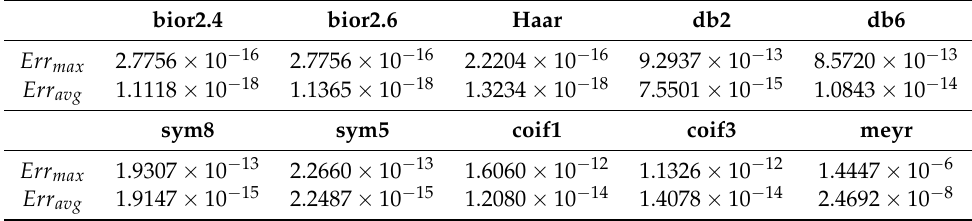
Figure 3. ( a ) Echos filtered by moving averaging methods; ( b ) echos filtered by wavelet-based methods; and ( c ) a specific echo filtered by wavelet-based methods. Table 1. Comparisons on reconstruction errors of six kinds of wavelets with impulse radio-ultra wideband radar